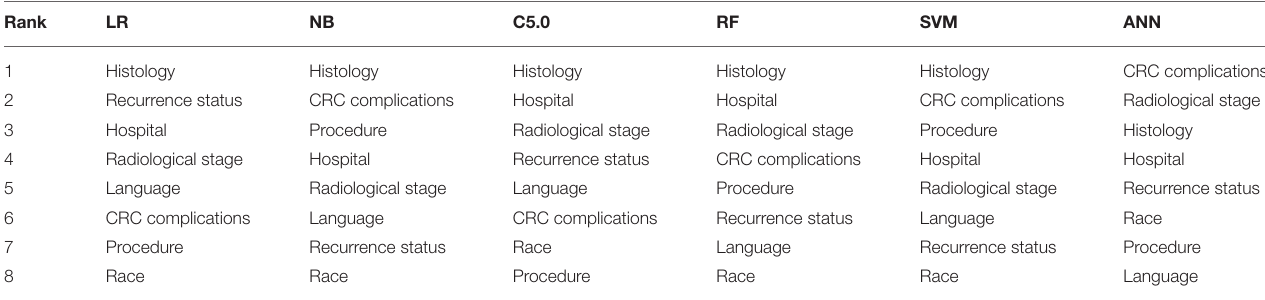
TABLE 3 | Risk factor ranking in descending order showing the relative importance of each feature to modelling WDGMC CRC survival as ranked by each predictive